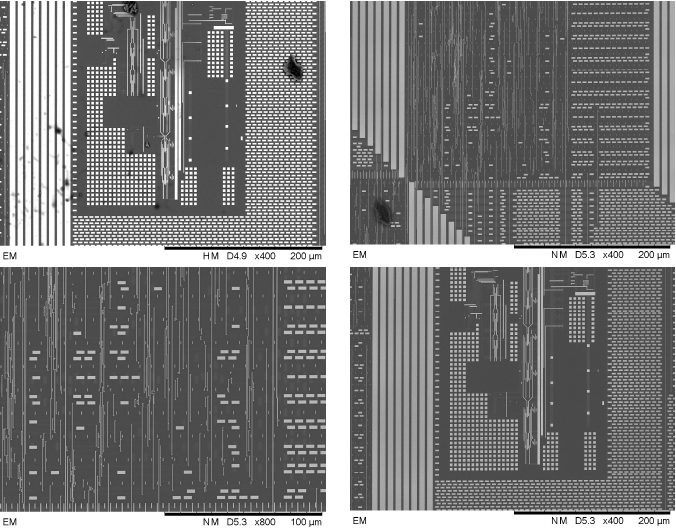
Figure 2. The partial views of the real-world chip’s